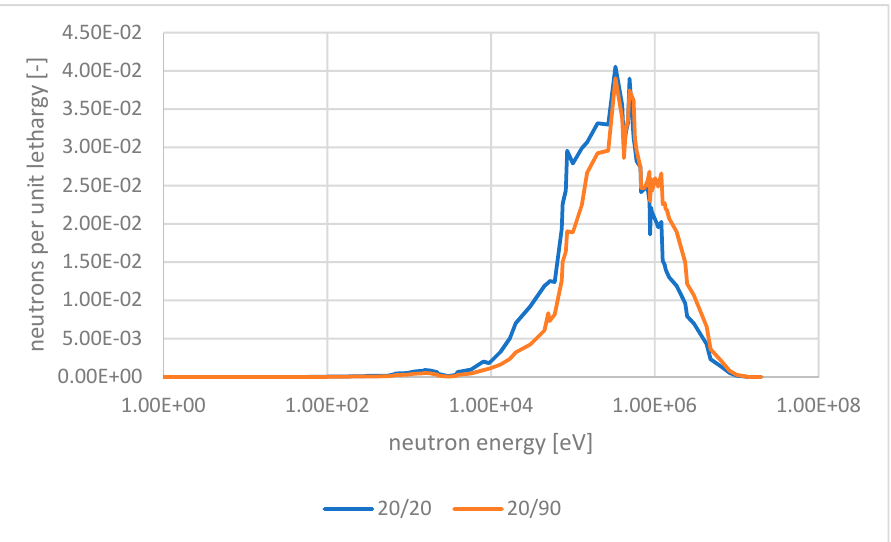
Figure 11. Neutron spectrum for the heavy metal rich system (20% NaCl) with 20% enrichment (20/20) compared to the 90% enriched system (20/90) (calculated through POLARIS).